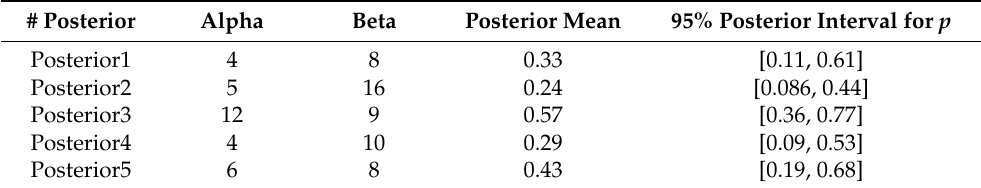
Table 3. Parameters of each posterior distribution for the first application (sample with n = 10, k = 3).